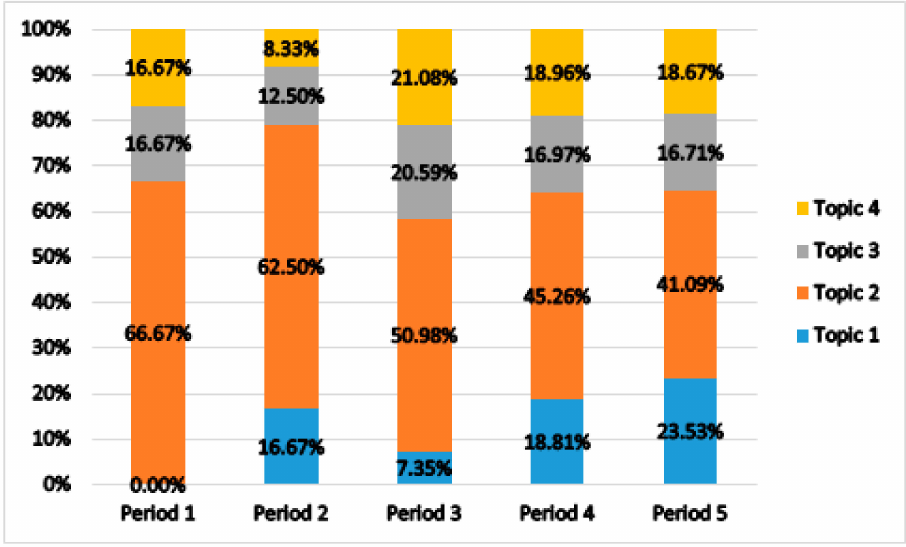
Figure 4. Topic trend by